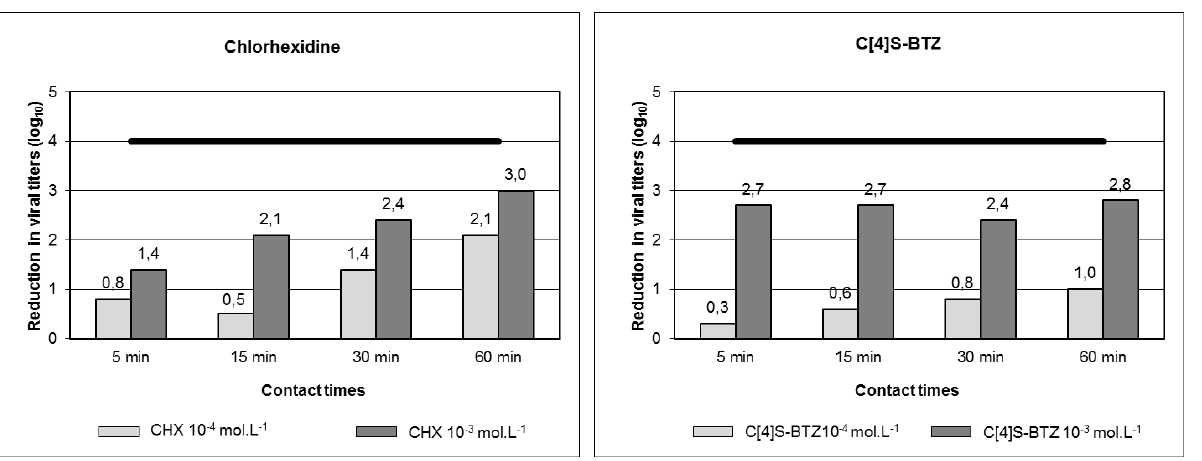
reduction to qualify as an 10